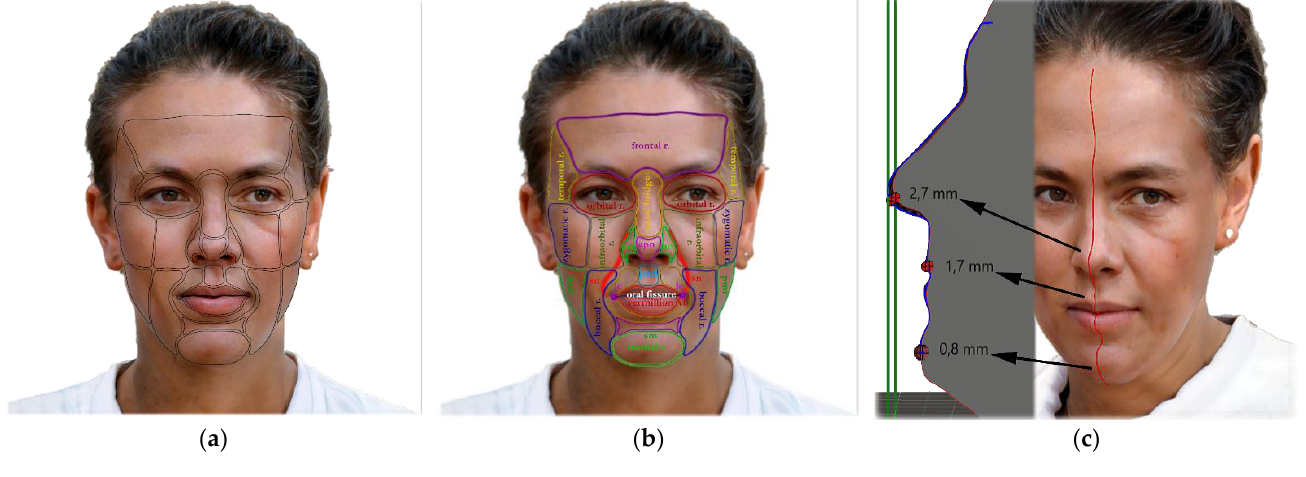
Figure 3. AI face generator was used to create this hermaphrodite face. It shows: ( a ) Observed facial locations; ( b ) Abbreviations of locations used: region (r.), parotid-masseteric region (pmr), labials commissure (lc), ala nasi (an), apex of nose (apn), sulcus nasolabialis (sn), sulcus mentolabialis (sm), vermillion border (vb), philtrum (phil); ( c ) Example of comparison of sagittal sections of the facial profile of the CBCT surface shell and the Bellus 3D shell. In this way, the differences between the shells were measured and the results of the differential maps were checked in the median plane. Table 1. Clinical evaluation of amount of deviation between CBCT and 3D TrueDepth (Bellus3D Dental Pro) scans.